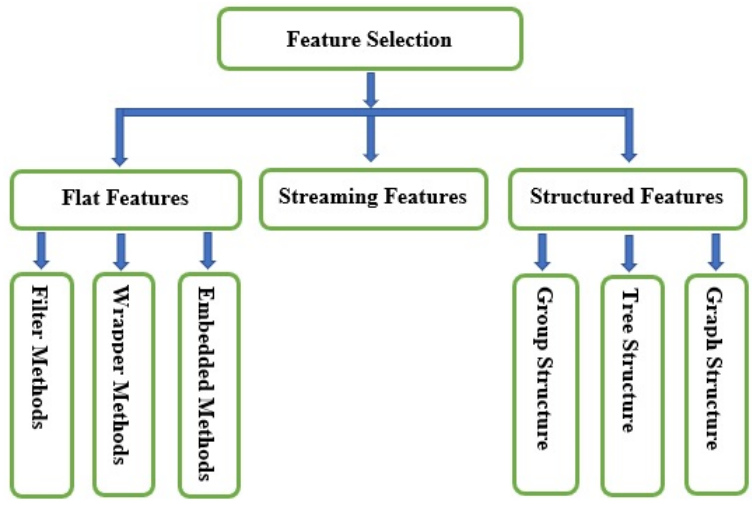
ff erent types of feature selection Figure 2. Different types of feature selection methods. Figure 2. Di